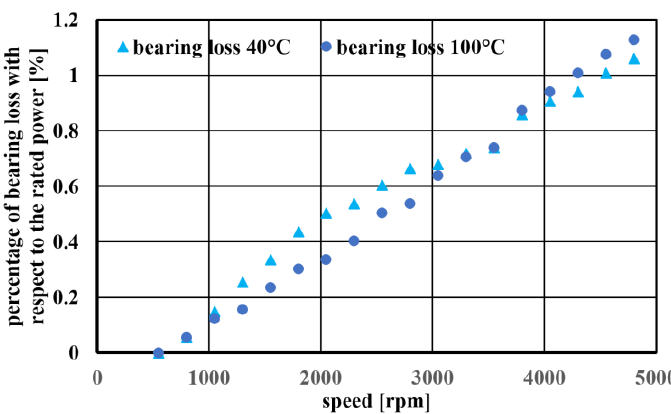
Figure 9. The mechanical loss variation in a 14.9 kW axial-flux PM motor against speed in two different temperature machines. The data to plot this figure was collected from [136].